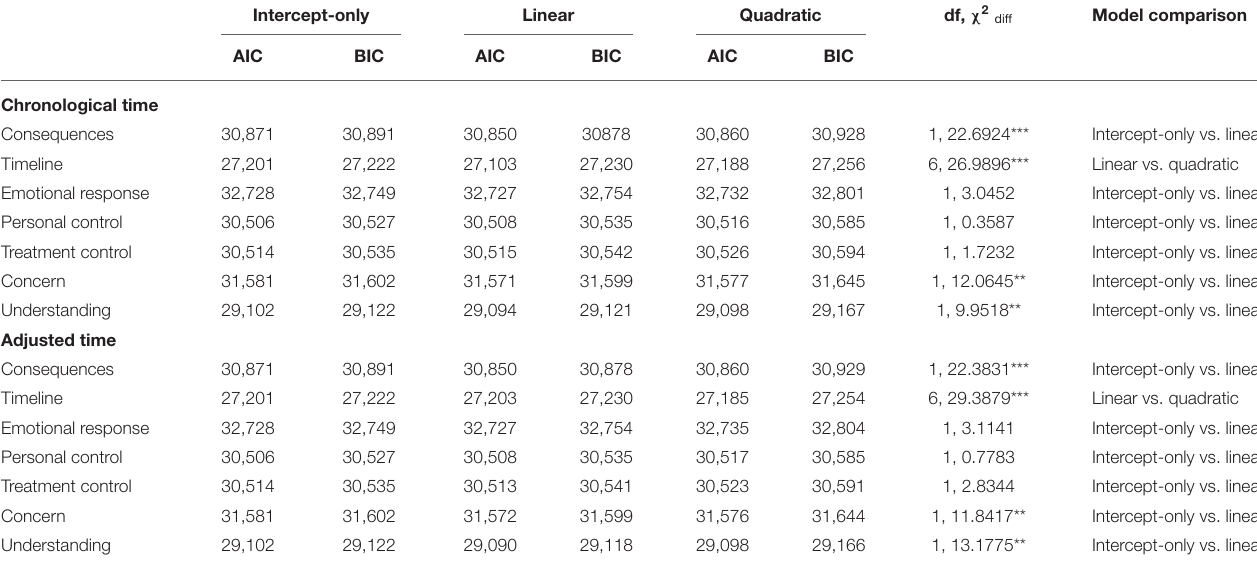
TABLE 3 | Model fit information regarding growth curves optimal functions for chronological and adjusted time. Intercept-only Linear Quadratic df, χ 2 diff Model comparison